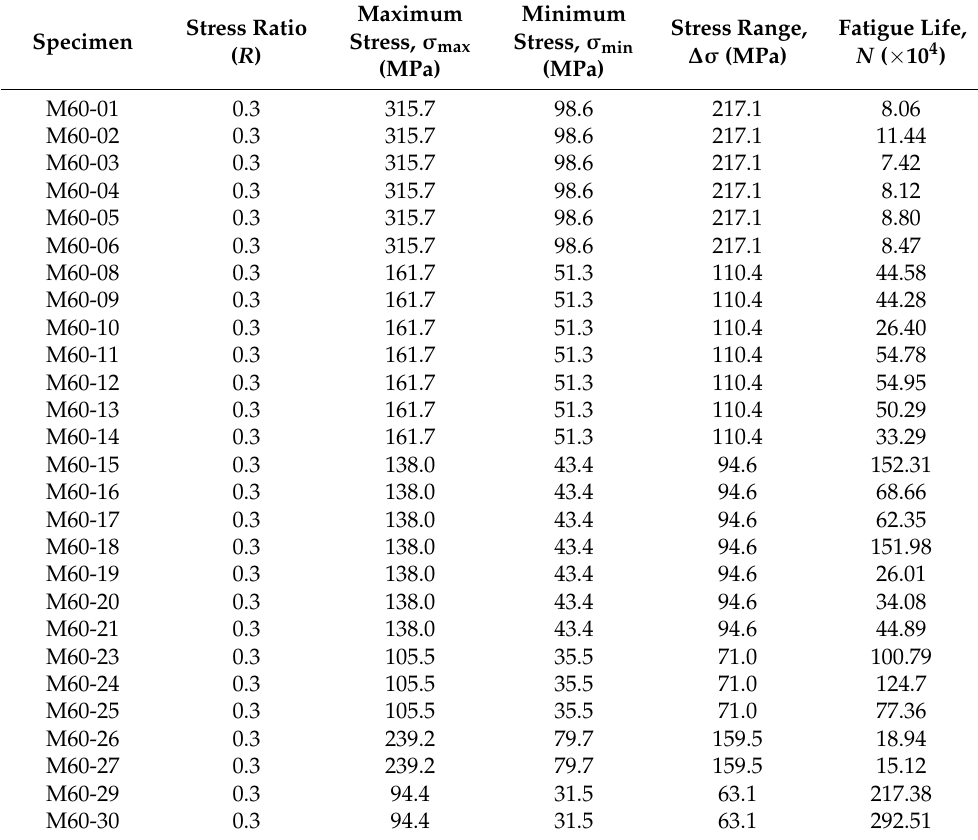
Table 3. The fatigue test results of M60 high-strength bolts under constant